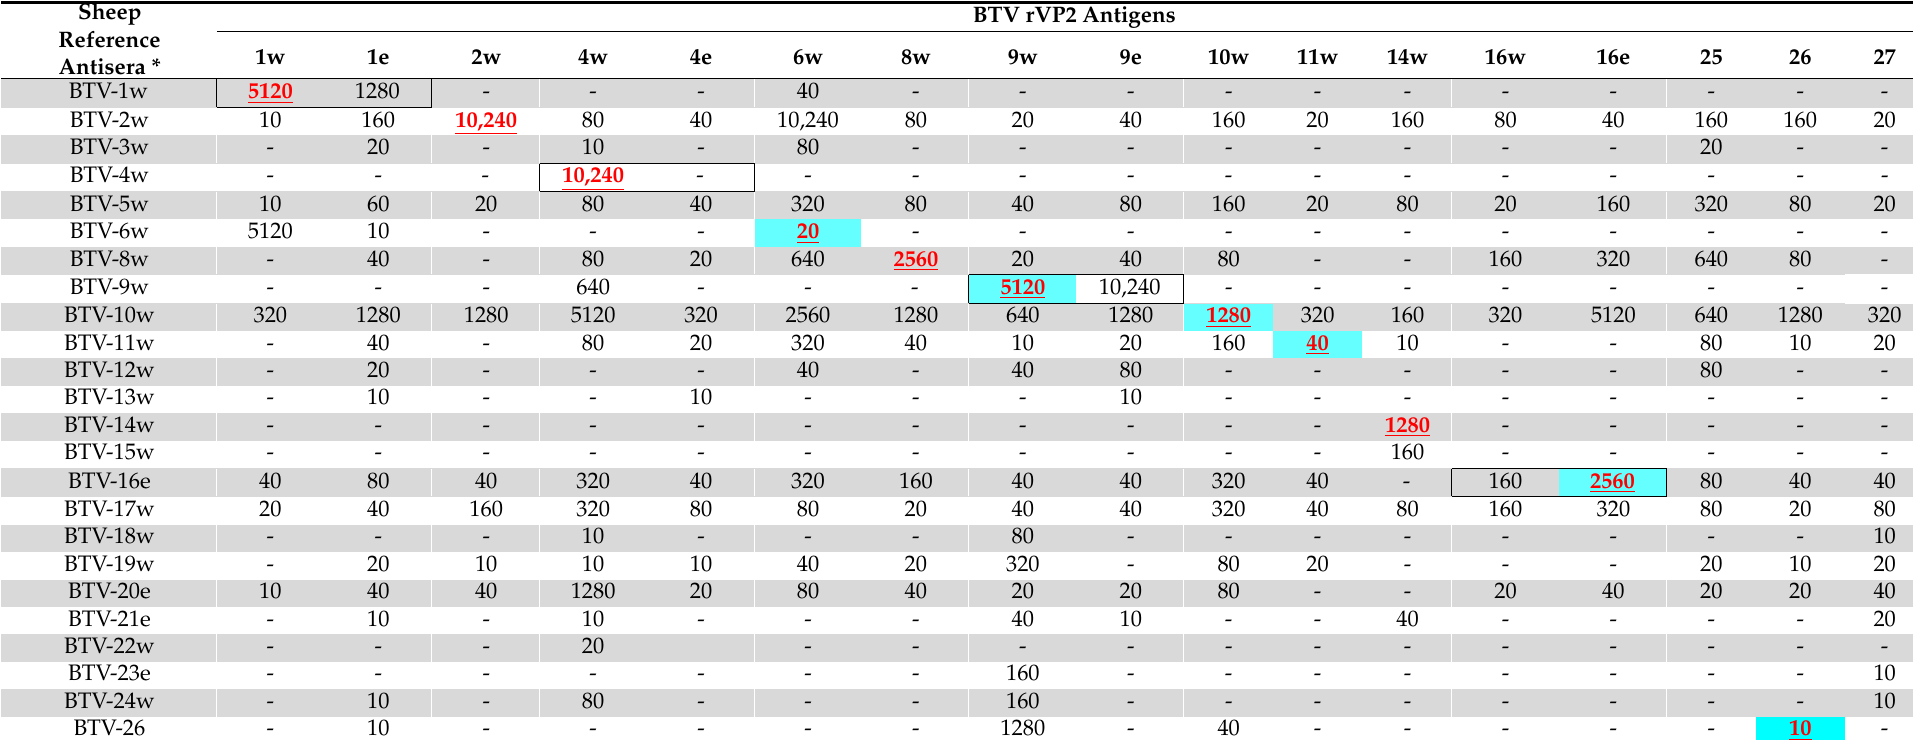
Table 4. I-ELISA titres for the sheep reference antisera against BTV-rVP2